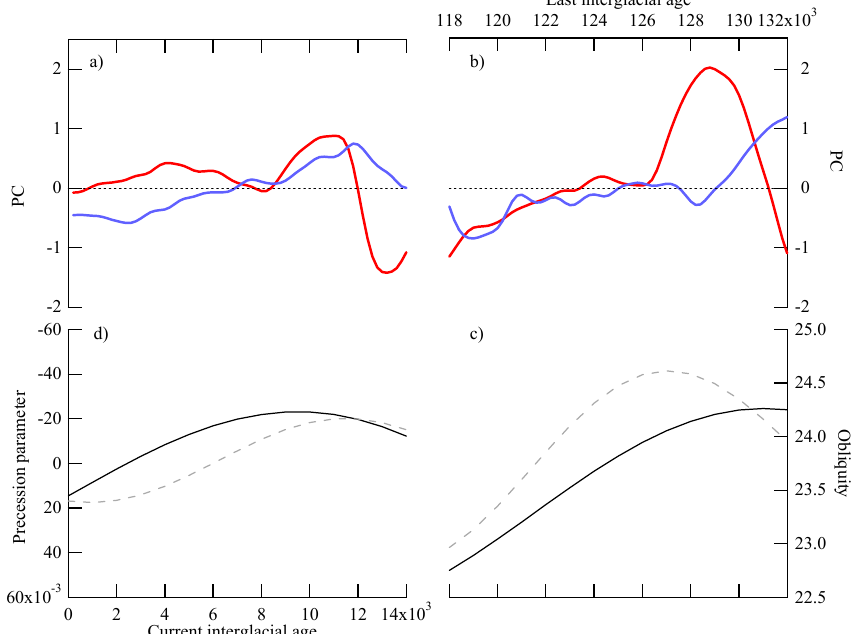
14x10 3 121086420 Current interglacial age Fig. 6. (a) Common and residual signals highlighted by principal component analyses, showing the first (red) and second (blue) principal components of the 5 δ 18 O records (TD not included) together with the percentage of variance explained, for the Holocene (expressed in ‰ anomalies). (b) Same as (a) but for the last interglacial. (c) Last interglacial orbital context, as displayed by variations in obliquity (thick black line) and reversed precession parameter (dashed grey line) (Laskar et al., 1993). (d) Same as (c) but for the Holocene.